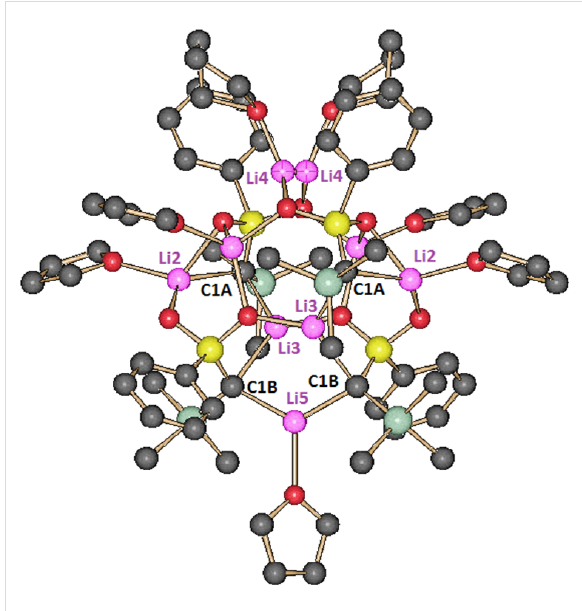
Figure 2: Structure of ( 2a ) 4 ·(THF) 6 in the crystal. Color code: black, C; green, Si; yellow, S; red, O; pink, Li. Hydrogen atoms are omitted for clarity. Lithium atoms Li1 are unmarked because of a lack of space.